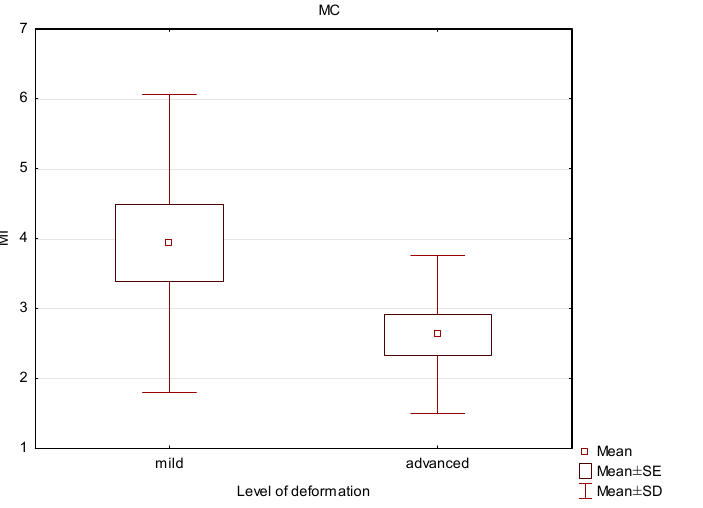
Figure 11. Box and whisker plot of the mineralization index (MI) in patients with mild and severe deformities in the medial condyle (MC).